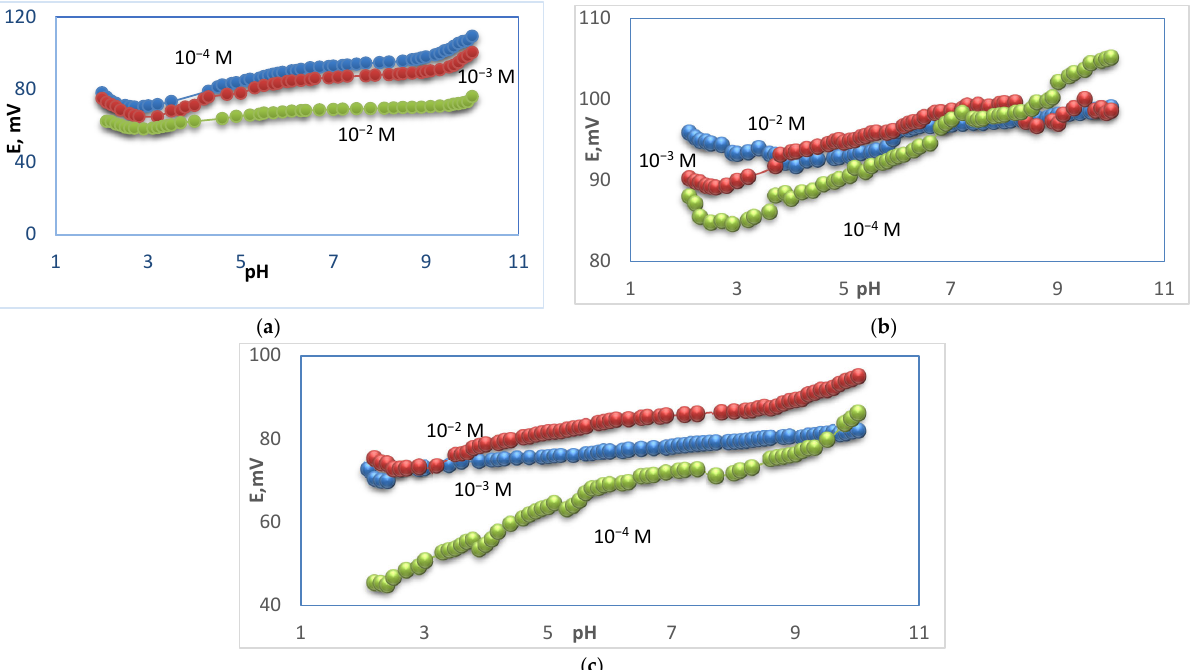
Figure 4. pH–effect of Ca–electrode for 10 − 2 , 10 − 3 , 10 − 4 M Ca 2+ solutions for electrode types I ( a ), type II ( b ), and type III ( c ) .